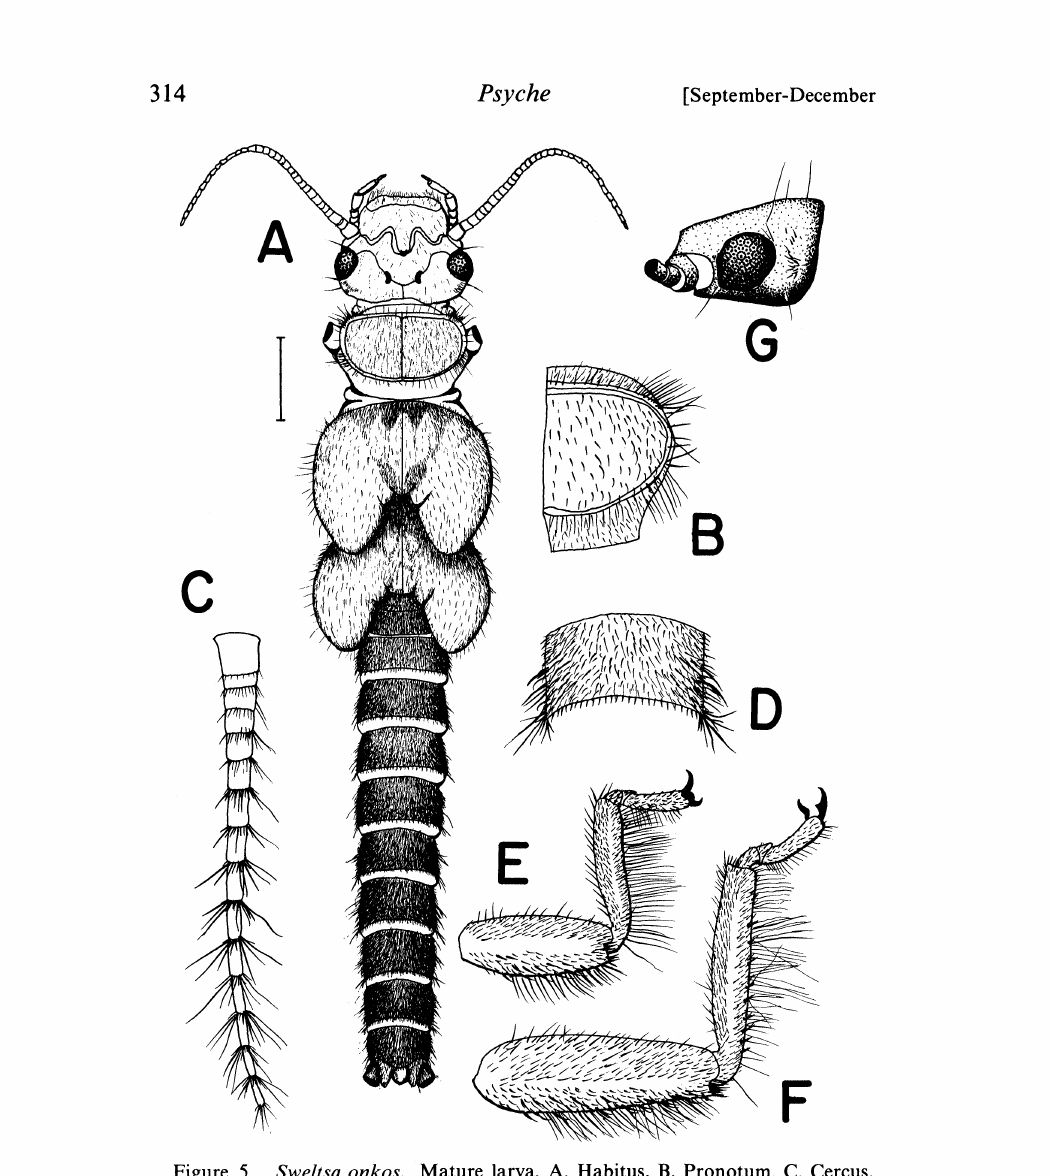
Figure 5. Swe#sa onkos. Mature larva, A. Habitus, B. Pronotum, C. Cercus, lateral view, D. Eighth tergite, E. Right foreleg, F. Right hindleg, G. Left lateral view of head. New Hampshire, Grafton Co., W. Thornton, Bear Brook, June, 1974, S. B.